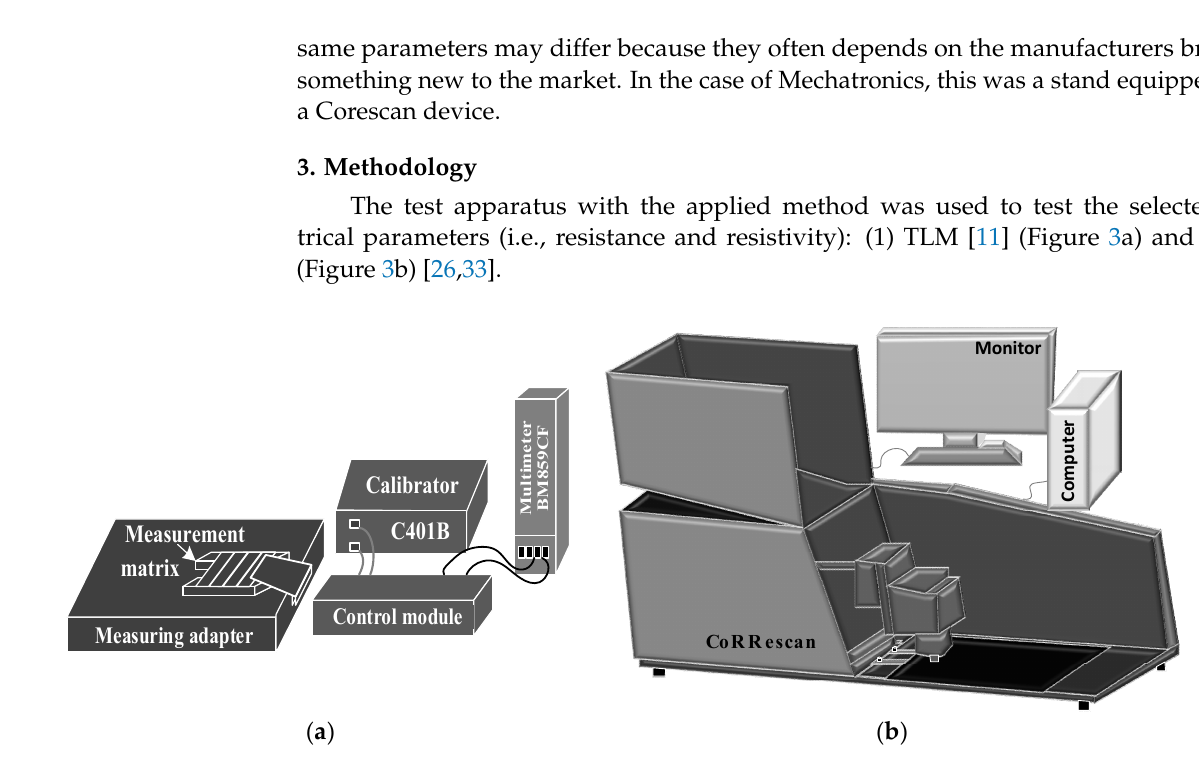
Figure 3. Determination of electrical parameters by the method of ( a ) TLM with the use of laboratory equipment and ( b ) PD with the use of industrial equipment.